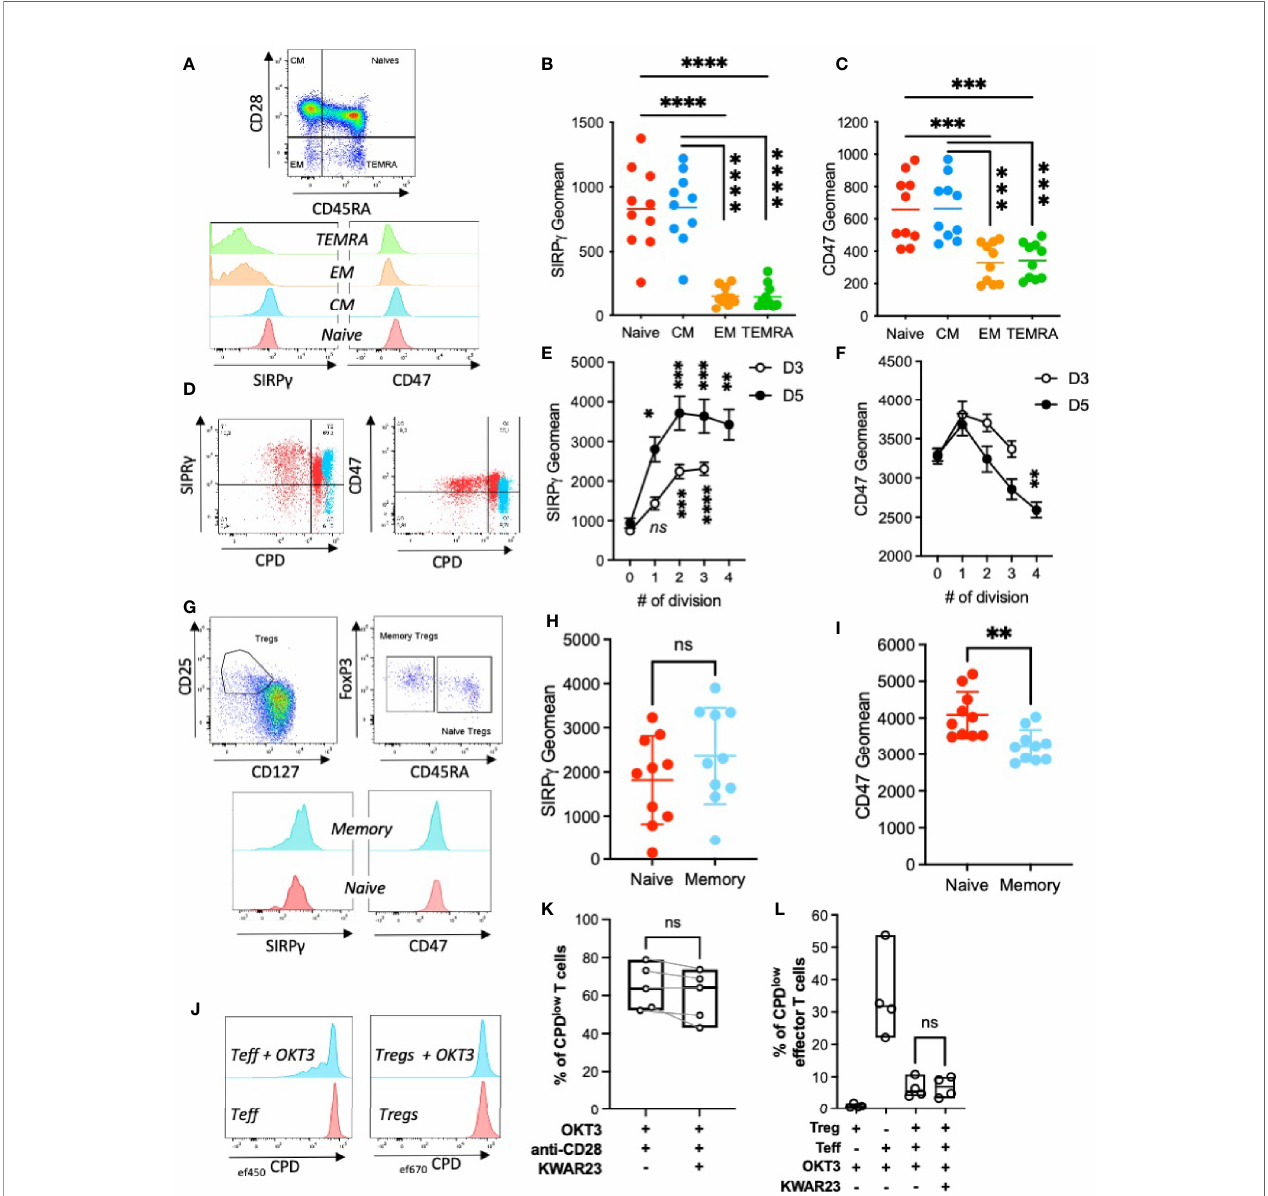
FIGURE 2 | SIRP g expression varies on T-cell subpopulations, upon T-cell activation and is not implicated in Tregs function. (A) T-cell subpopulations gating strategy and their SIRP g and CD47 expressions. (B) Geometric mean of SIRP g and (C) CD47 on T-cell subpopulations; each symbol represents independent HV. Statistical analysis was performed by a Friedman test followed by a Dunn ’ s multiple comparison test. (D – F) SIRP g and CD47 expressions were analyzed after T-cell stimulation with coated anti-CD3 and anti-CD28 mAbs. (D) Overlay allowing the comparison of SIRP g (left) and CD47 (right) expression on unstimulated puri fi ed T cells (i.e., Day 0 in blue) vs . proliferating CPD low T cells (i.e., Day 5 in red). (E) Geometric mean (± SEM) of SIRP g or (F) CD47 on T cells as a function of their number of divisions, n = 10 HV analyzed in two independent experiments. Kruskal-Wallis test was used. (G) Treg gating strategy based on CD25 and CD127 expression is represented as dot plots; representative histograms of SIRP g and CD47 staining on Tregs subpopulations are shown. (H) Geometric mean of SIRP g or (I) CD47 on Tregs are plotted. Each symbol represents independent HV. Statistical analysis was performed by a Friedman test followed by a Dunn ’ s multiple comparisons test. (J) A representative histogram of T effector (Teff) and T regulatory (Treg) cell proliferation under control conditions is shown at Day 5. (K) The effect of SIRP g blockade with KWAR23 (10 µg/ml) was evaluated on T-cell proliferation upon OKT3 and anti-CD28 stimulation (both at 1 µg/ml). n = 2 independent experiments. (L) The consequences of SIRP g blockade on Treg suppressive function was assessed by coculturing ef450 CPD-labeled Teff with ef670 CPD-labeled Treg cells in the presence or not of stimulatory molecule (OKT3) with or without SIRP g blockade (KWAR23). Percentage of CPD low effector T cells (± SEM) is presented regarding culture conditions. n = 4 independent experiments. * p ≤ 0.05; ** p ≤ 0.01; *** p ≤ 0.001; **** p ≤ 0.0001; ns, not signi fi